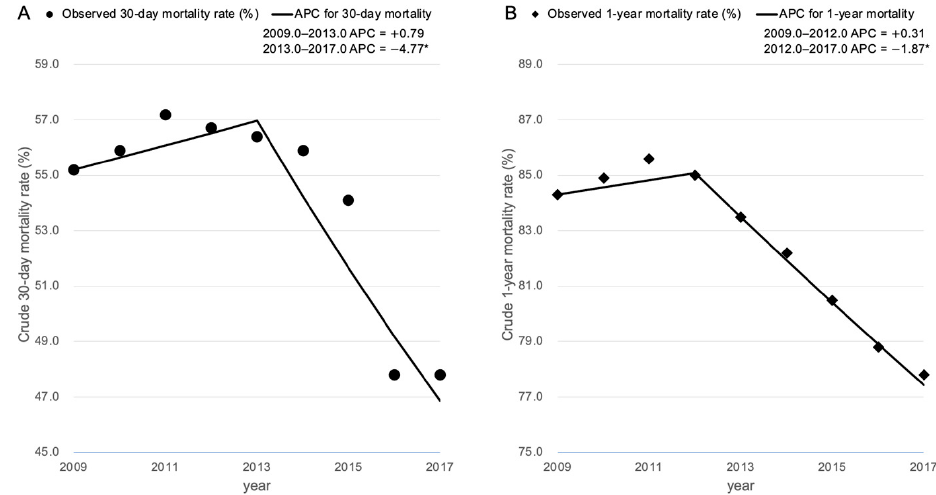
Figure 2. Join point regression analysis of mortality trends among adult active cancer patients with septic shock in Korea between 2009 and 2017. ( A ) 30-day mortality. ( B ) 1-year mortality. * Significantly different from zero ( p < 0.05). APC indicates annual percentage change.